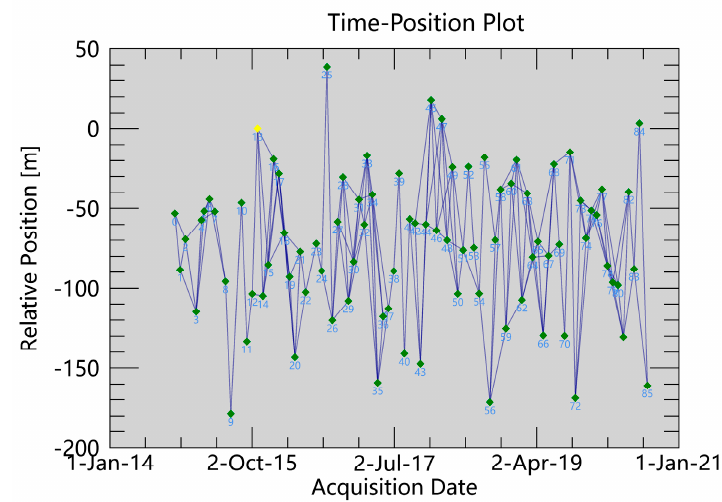
Figure 5. Time-Baseline map of Sentinel-1A ascending data.